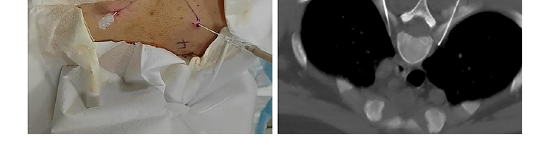
FIGURE1 Body surface localization (A) and radiofrequency targeting points (B) of CT-guided thoracic sympathetic nerve radiofrequency thermocoagulation using the T4 segment as an example.